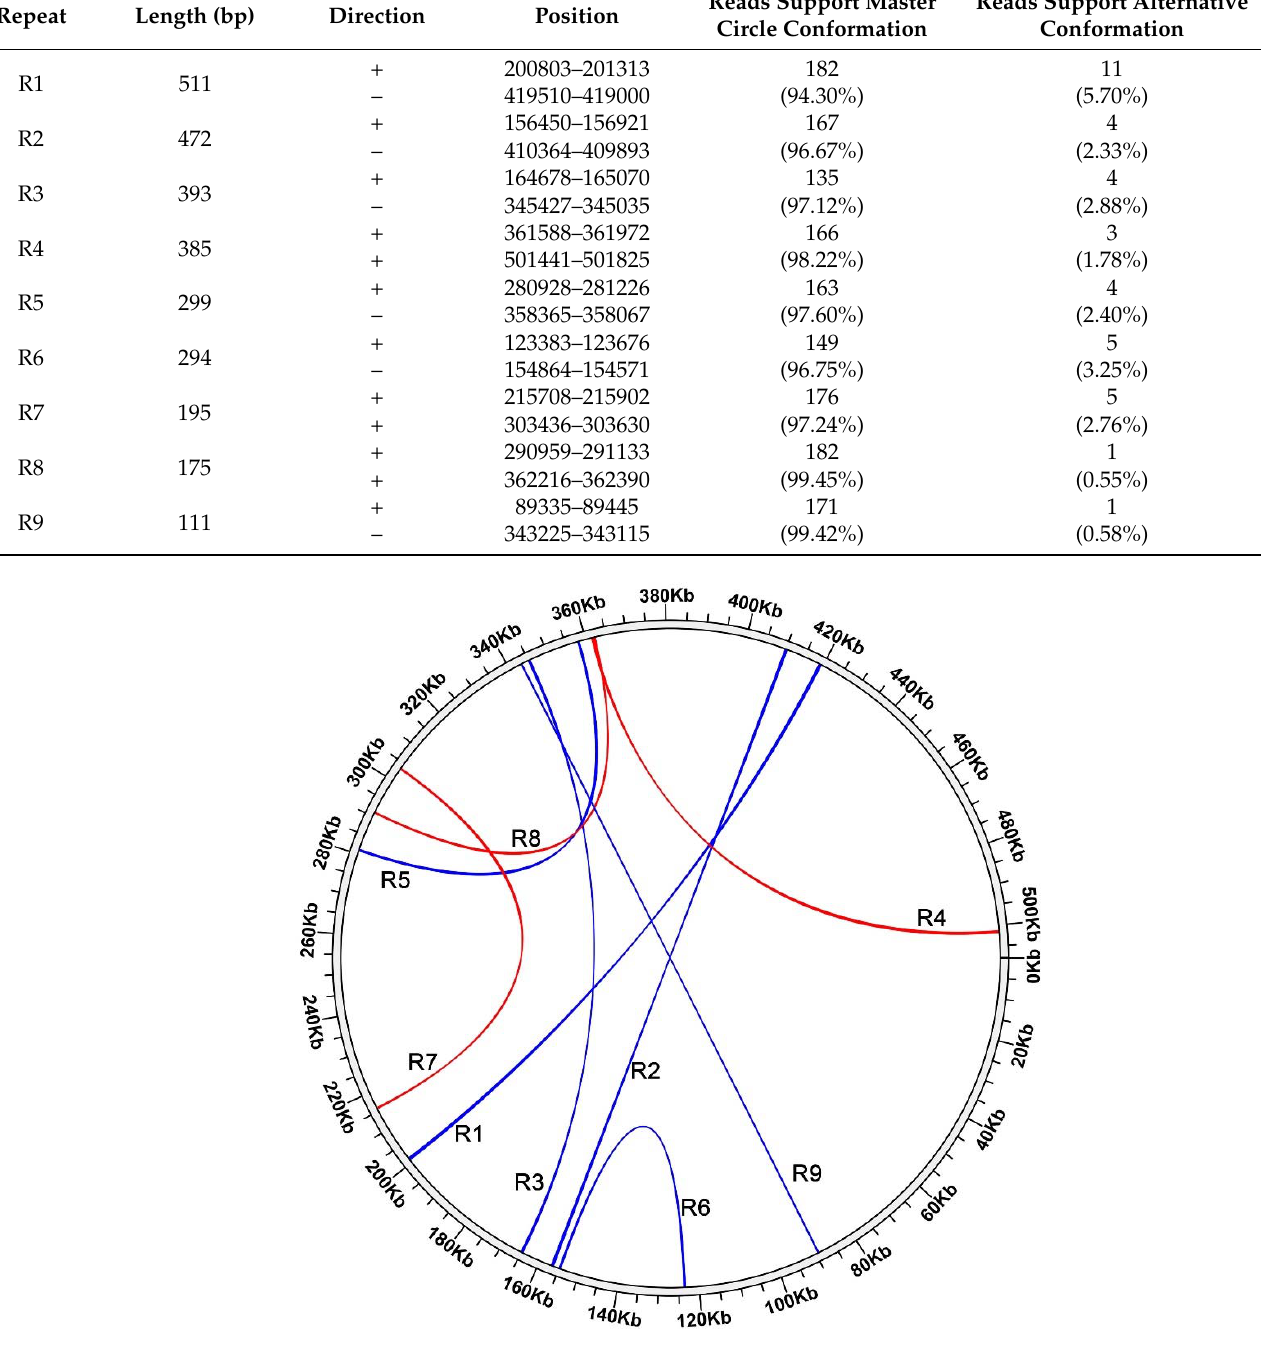
Figure 3. The distribution of the nine pairs of repeats which could mediate recombination in P. salicina mitogenome. The arcs show the linkage of direct (red) and inverted (blue) repeats (R1 to R9) with evidence for recombination activity. Numbers on the outer circle represent genome coordinates